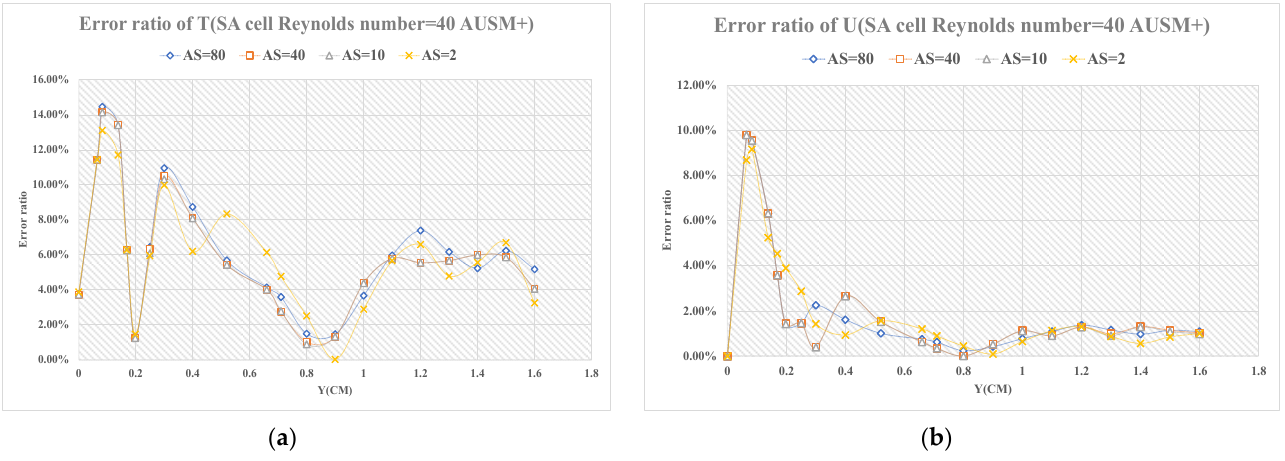
Figure 24. ( a ) error ratio distribution diagrams of T at S = 0.105 m; ( b ) error ratio distribution diagrams of U at S = 0.105 m.